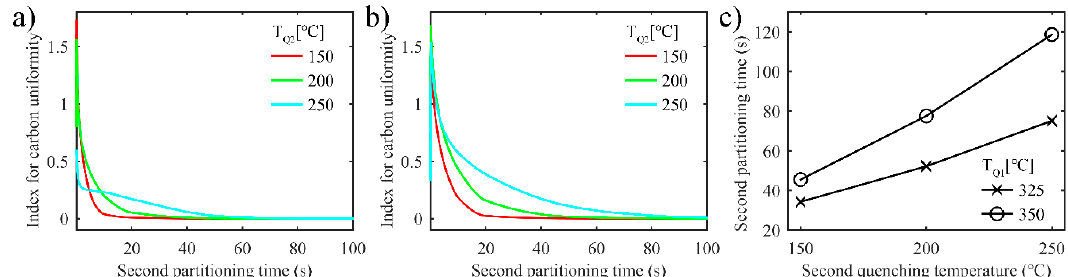
Figure 11. Uniformity of carbon distribution in austenite in the two-stage Q-P process. ( a ) The index for carbon distribution uniformity versus second partitioning time. T Q1 = 325 °C, T P1 = 425 °C and the partitioning time is 10 s; T P2 = 350 °C and the partitioning time is 100 s; ( b ) The index for carbon distribution uniformity versus second partitioning time. T Q1 = 350 °C, T P1 = 425 °C and the partitioning time is 10 s; T P2 = 350 °C and the partitioning time is 100 s; ( c ) The second partitioning time when carbon concentration reaches 3.1 wt.% in each grid of austenite versus second quenching temperature.